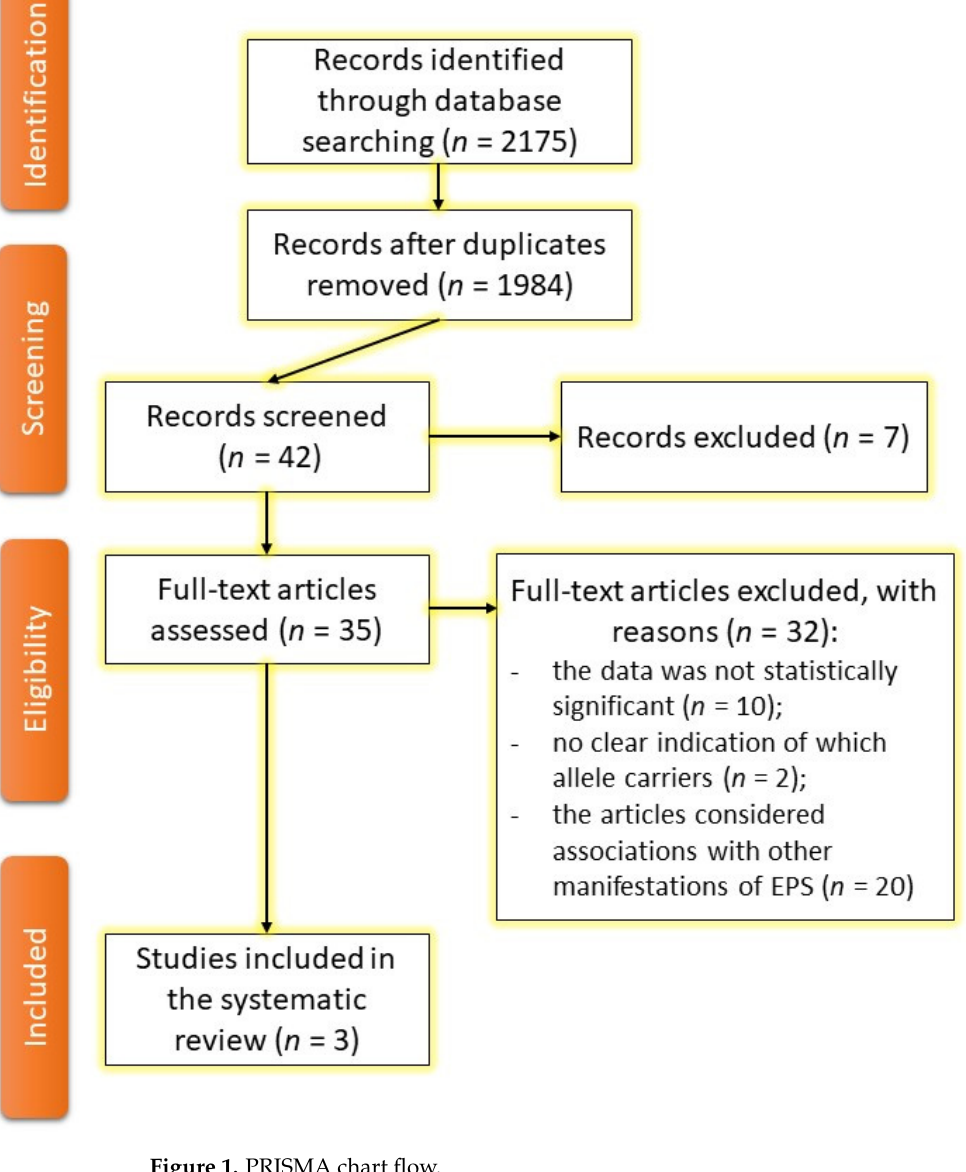
Figure 1. PRISMA chart flow.